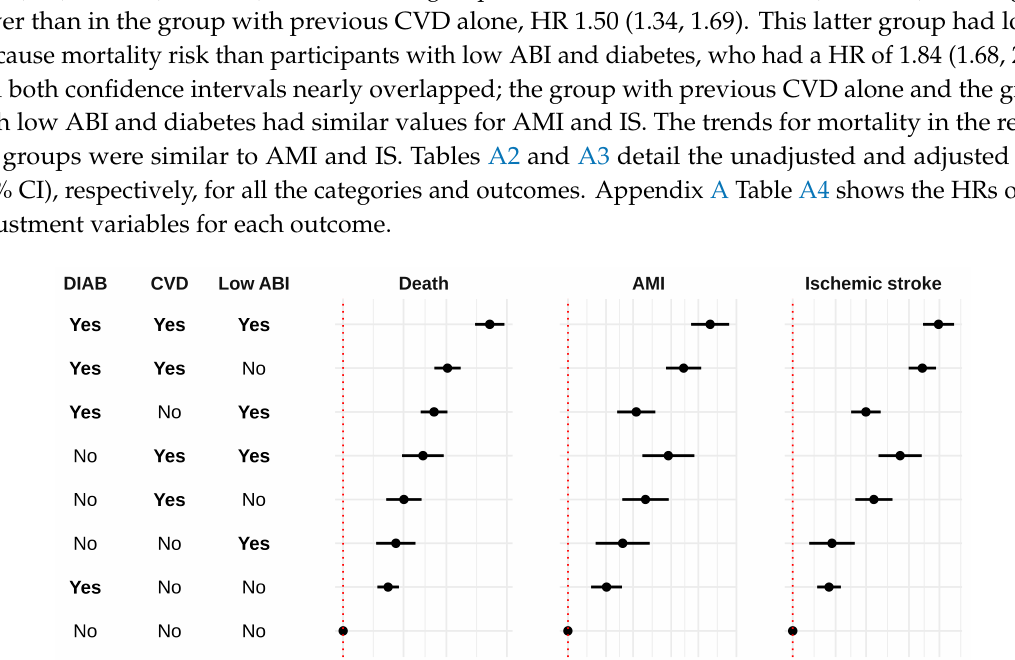
Table 2. Raw incidences of all-cause mortality, acute myocardial infarction, and ischemic stroke by population groups.